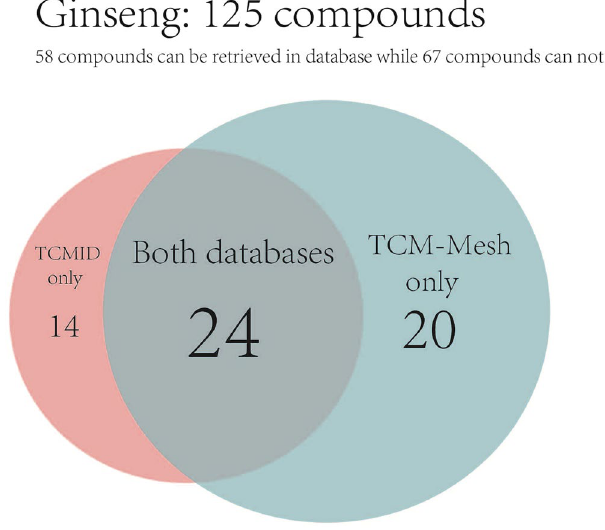
Figure 3. The comparison result of TCM-Mesh and TCMID by using compounds of ginseng. The number in the circle represented the amount of compounds that could be retrieved with hits in the databases.